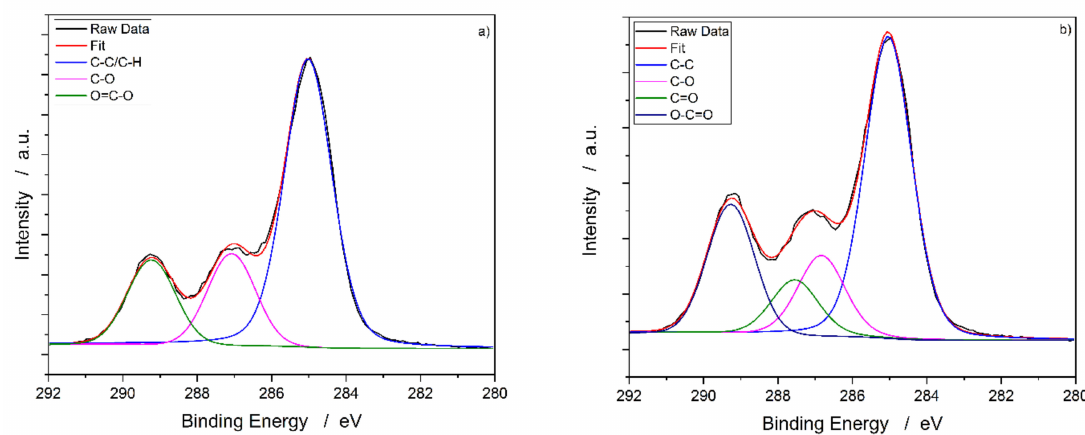
Figure 2. XPS raw data of the C1s carbon peak and fitted Voigt profiles of PLA WPC measurements. ( a ) Spectra before plasma treatment with three fits corresponding to the three bonds present in PLA (C–C / H, C–O and O–C = O). ( b ) The spectra after the treatment reveals an increase in the O = C–O and the formation of a new C = O